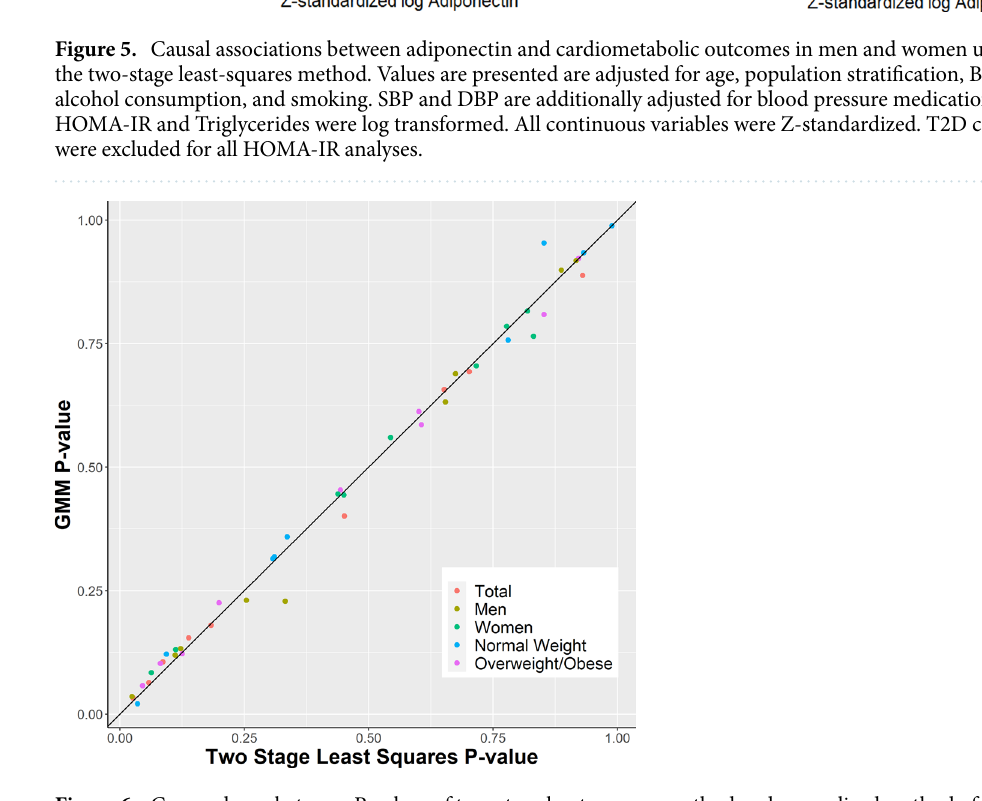
Figure 6. Concordance between P-values of two-stage least-squares method and generalized method of moments (GMM) for all